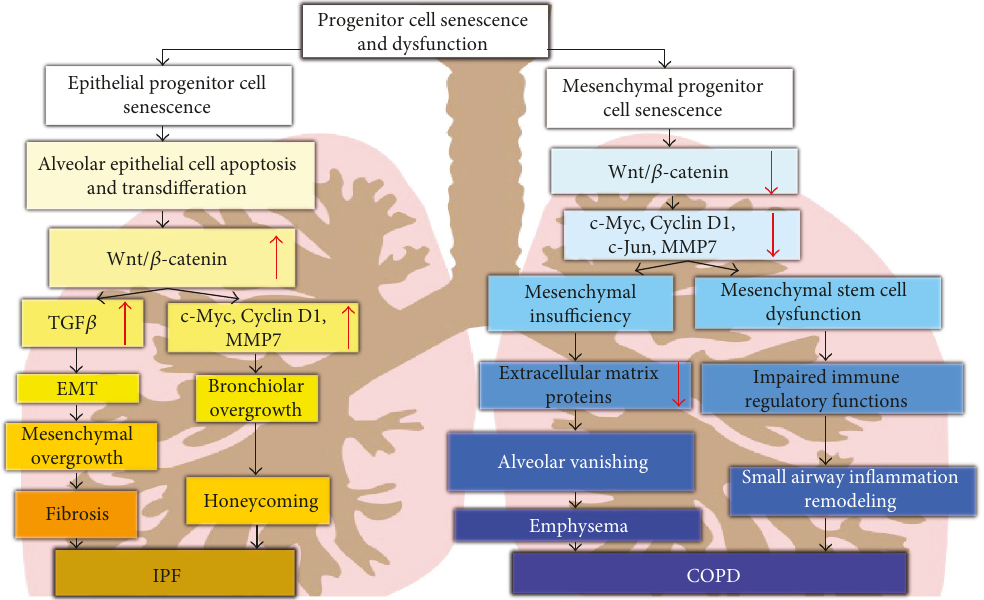
Figure 2: Scheme of possibly distinct pathogenic role of Wnt/ β -catenin signaling in COPD and IPF. Possible mechanisms of Wnt/ β -catenin signaling in the pathogenesis of COPD (right) and IPF (left) are proposed based on the literatures. In IPF, an enhanced Wnt/ β -catenin signaling of epithelial cells interacts with TGF- β to promote EMT, which leads to mesenchymal overgrowth and fi brosis. On the other hand, activated Wnt signaling can increase the expression of Wnt target genes related to cell proliferation and ECM, which leads to bronchiolar overgrowth and honeycombing. In the case of COPD, a decreased Wnt/ β -catenin signaling activity in the mesenchymal compartment results in the reduced expression of Wnt target genes related to cell proliferation, leading to mesenchymal de fi ciency and the reduction of ECM protein expression in alveolar cells, accordingly the development of emphysema or dysfunctions MSCs and immune regulations in small airway, which leads to enhance in fl ammation in